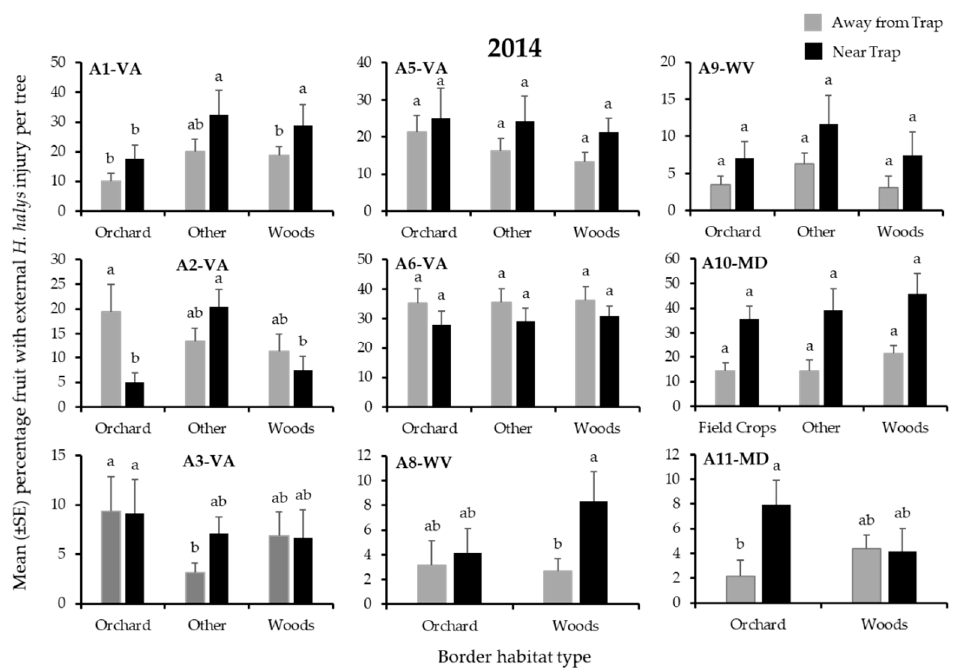
Figure 5. Mean ( ± SE) incidence of H. halys external injury to apples per tree at harvest (2013), from trees on the perimeter of 9 apple orchard blocks in the Mid-Atlantic, USA, that were bordered by various habitats. Because all fruit harvested in 2013 were from trees adjacent to pheromone-baited traps, injury may have been inflated. Bars with shared letters are not significantly different (Tukey HSD, α = 0.05).